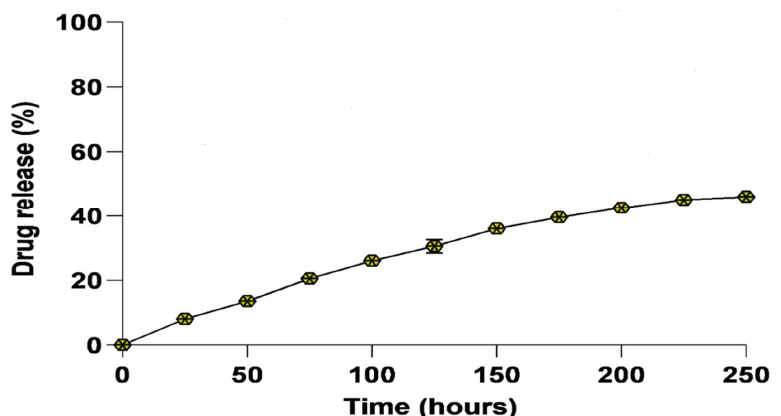
Figure 2. Release kinetics of AmB nano-assembly. Release kinetics of monomeric AmB from the as-synthesized nano-assembled AmB in phosphate buffer saline (PBS) at pH 7.4 at 37 °C. The AmB released at different time periods was evaluated at 408 nm using a UV-Vis spectrophotometer. Each point depicts an average of three estimations ± SD.